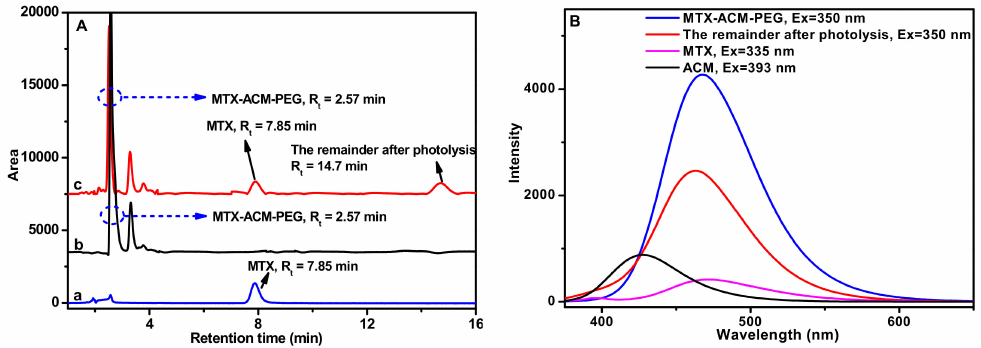
Figure 2. The photosolvolysis process of MTX-AMC-PEG conjugate, ( A ) HPLC spectra of native MTX ( a ), blank MTX-AMC-PEG ( b ) and the products after the photolysis of MTX-AMC-PEG ( c ); ( B ) the fluorescence spectra of native MTX, AMC, blank MTX-AMC-PEG, and the remainder after photolysis in PBS (pH